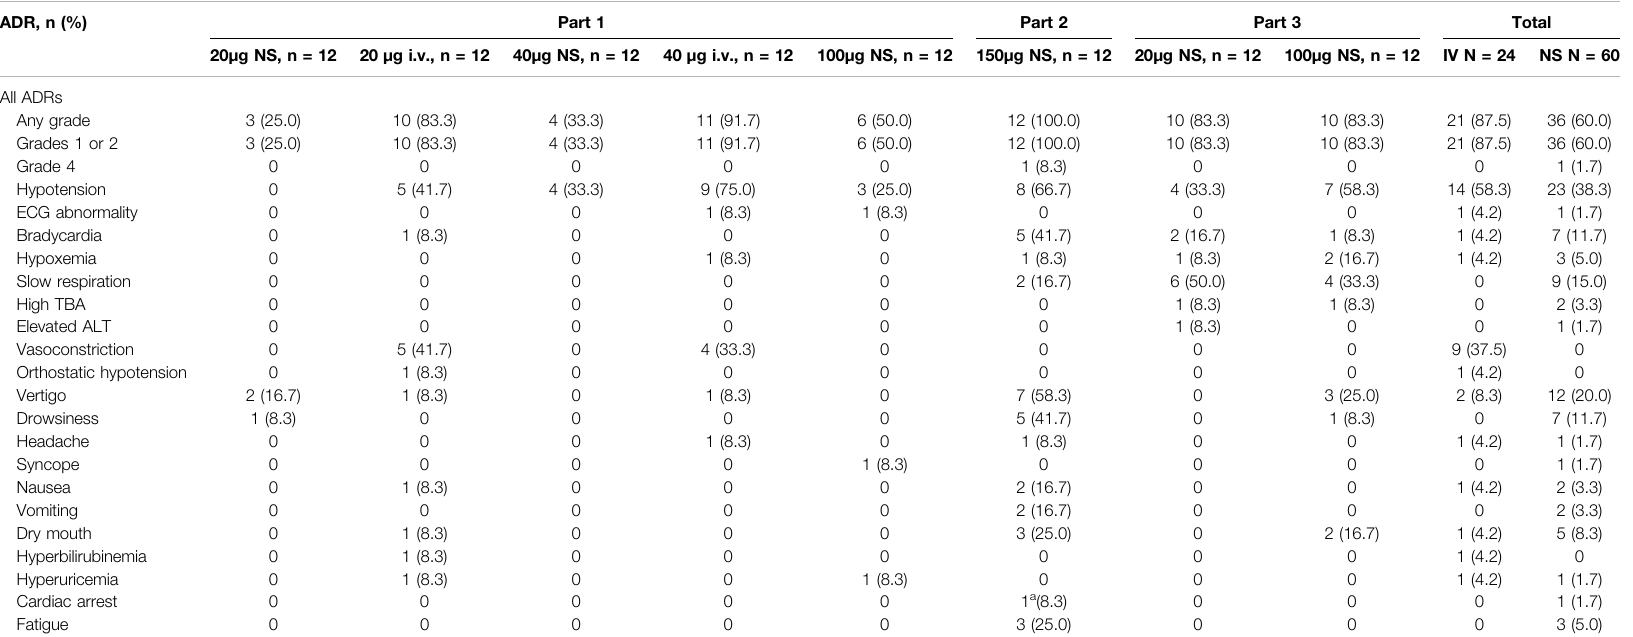
TABLE 2 | ADRs of healthy subjects after a single dose of dexmedetomidine nasal spray or injection. ADR, n